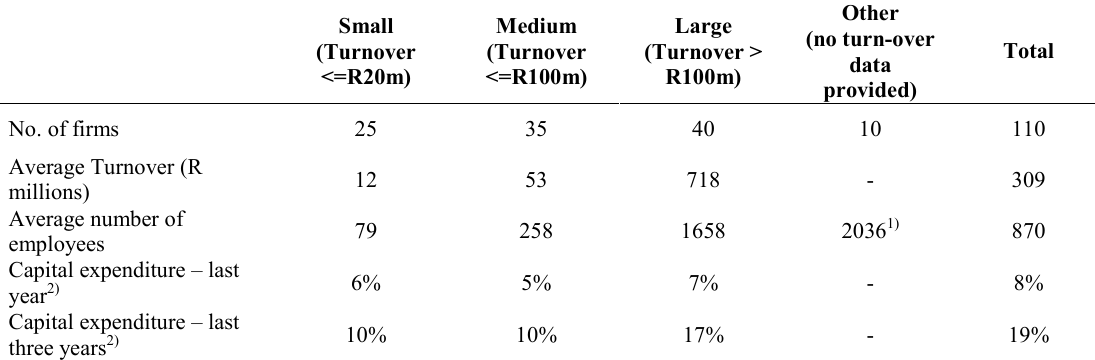
Table 1: Details of respondent firms